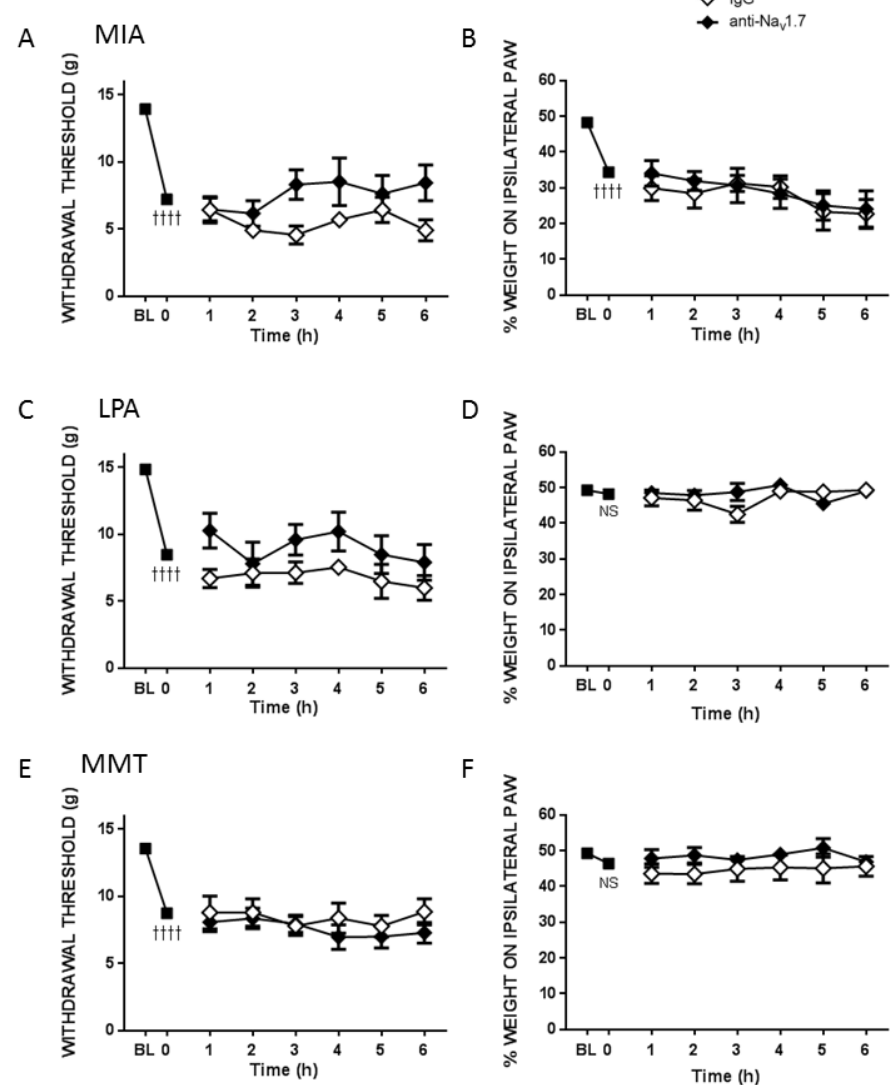
Figure 5. Acute Effect of anti-Na v 1.7 Treatment on Joint Pain. Local, subcutaneous injection of anti-Na v 1.7 (25 µ g in 50 µ L) over the knees of MIA ( A , B ), LPA ( C , D ), and MMT ( E , F ) animals had no effect on hindpaw mechanosensitivity nor hindlimb weight bearing over the acute 6 h time-course compared to IgG controls, p > 0.05, two–way RMANOVA. †††† p < 0.0001, paired Student t -test of baseline (BL) vs. t = 0 min. Data are expressed as mean ± S.E.M ( n = 8–9 animals/group).